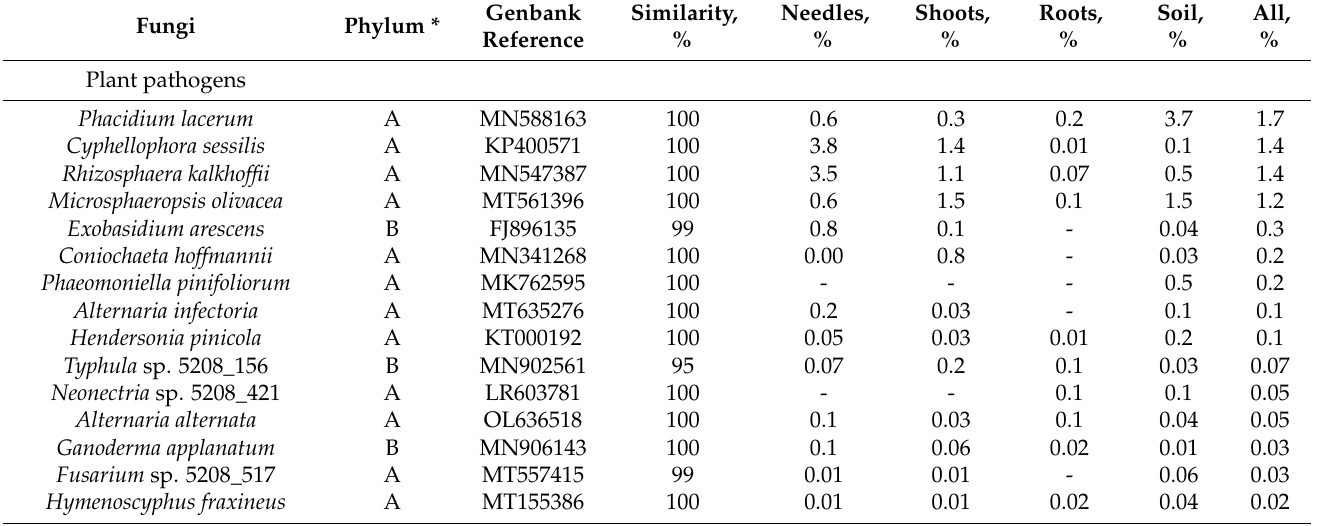
Table 4. Occurrence and relative abundance of the 15 most common plant pathogenic, mycorrhizal and endophytic fungi (shown as a proportion of all high-quality fungal sequences) found in different substrates of Picea abies . The data from different sites are